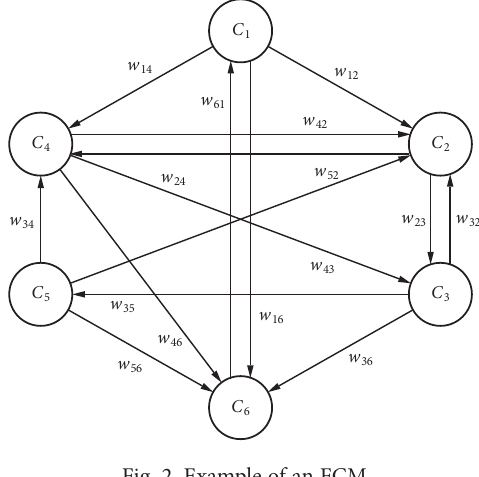
Fig. 2. Example of an FCM Source: Kang et al. (2012: